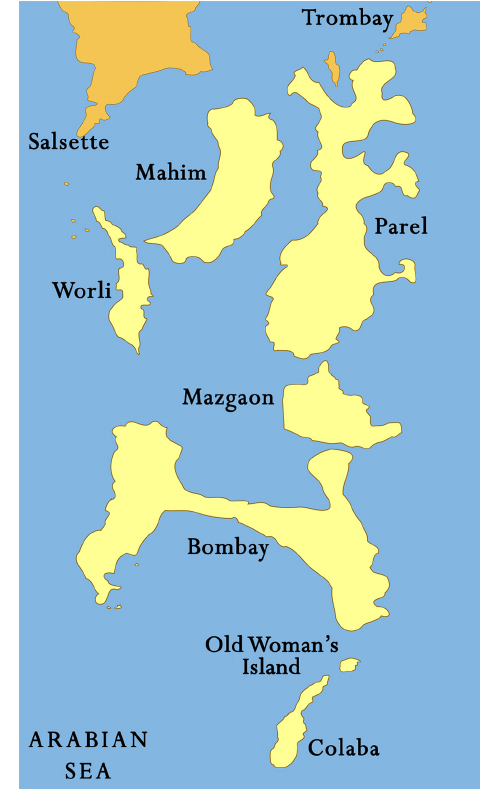
Figure 1. The collection of islands (modified from Kamath, 2000), separate and disparate, in the early 19th century that formed the Mumbai (Bombay) of today. Mumbai has developed from a bunch of virgin islands that were fused together to turn it into a bustling world-class